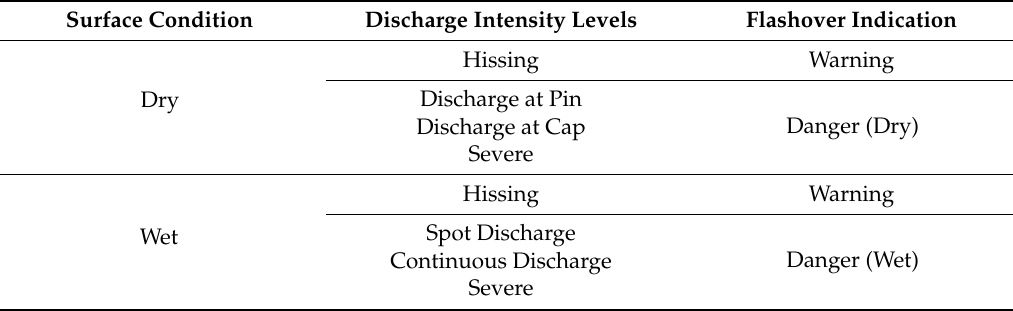
Table 5. Flashover indication